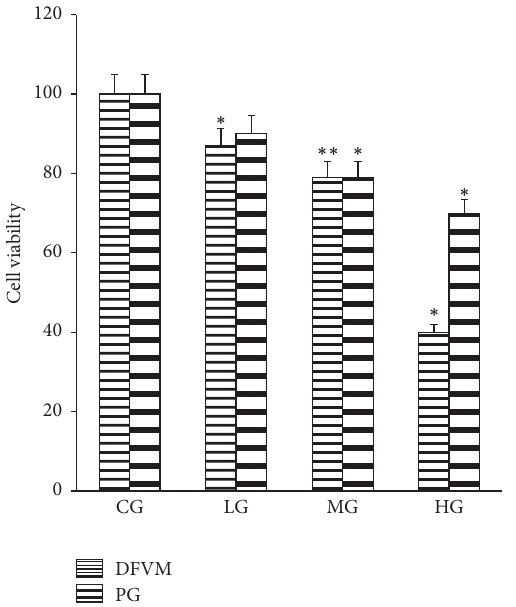
Figure 3: Effect of PFVM on cell viability. (CG was set at 100%). CG, control group; LG, low dose group; MG, medium dose group; HG, high dose group; PG, positive control group. ∗ 𝑃 < 0.05 , ∗∗ 𝑃 < 0.01 versus control